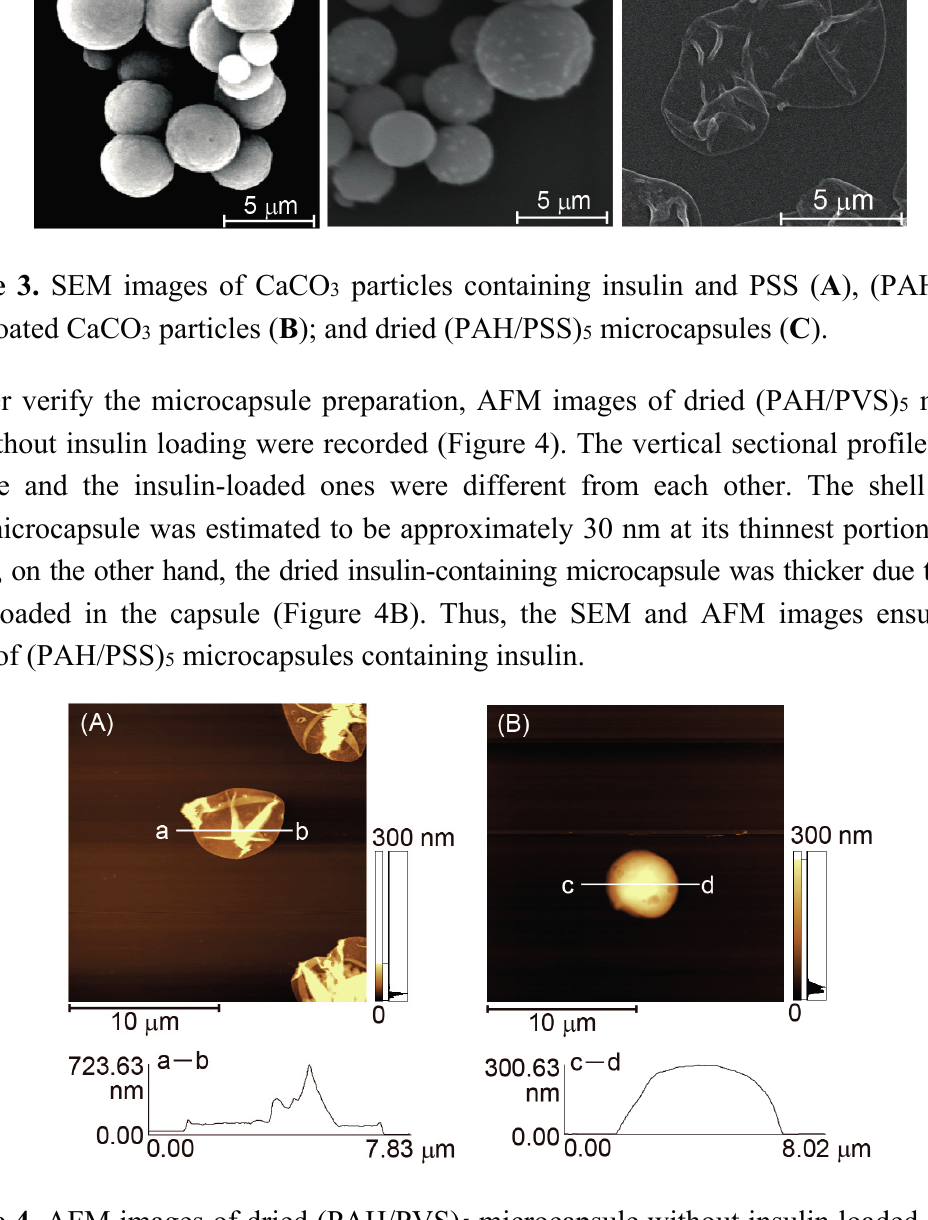
Figure 4. AFM images of dried (PAH/PVS) 5 microcapsule without insulin loaded ( A ) and microcapsules containing insulin-PSS aggregates ( B ). The sectional profiles a–b and c–d show thickness of the dried